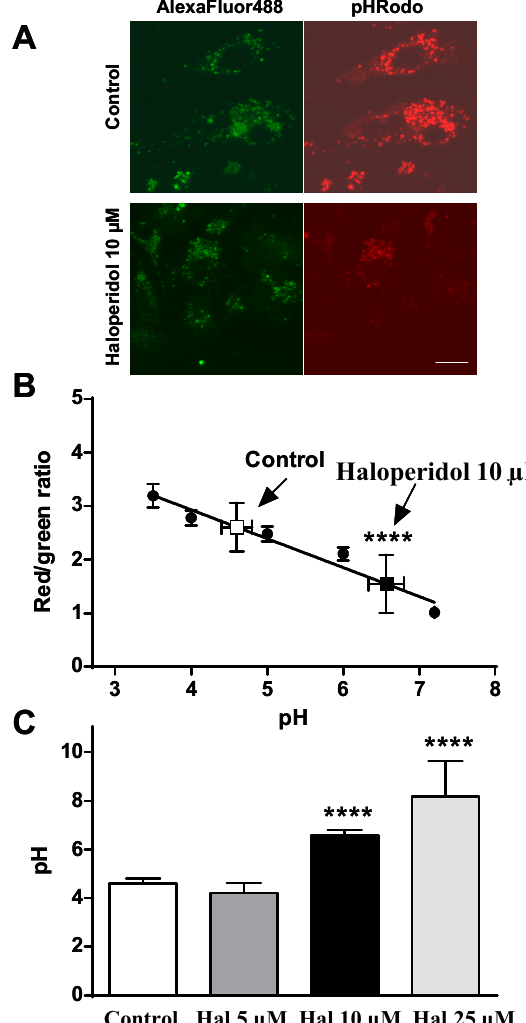
Figure 2. FGA haloperidol increases the lysosomal pH. HepG2 cells were incubated with LDL. (30 µg/mL of cholesterol) for 12 h in the absence (control) or the presence of haloperidol (Hal) (5, 10 or 25 µM) and pH-sensing fluorochromes Alexa Fluor 488-dextran and pHrodo-dextran. ( A ) Sample confocal images of control and 10 µM haloperidol treated culture dishes showing emission reduction of pH sensitive pHrodo (in red) relative to pH insensitive Alexa Fluor probe (in green). Scale bar, 5 µm. ( B ) Standard curve to calculate endogenous lysosomal pH where values of the red:green fluorescence ratio corresponding to control and haloperidol at 10 µM are indicated. ( C ) Effect of increasing concentrations of haloperidol on lysosomal pH. Results are mean ± SEM ( n = 3–15). Statistical comparisons shown are haloperidol versus control (**** p <0.0001).